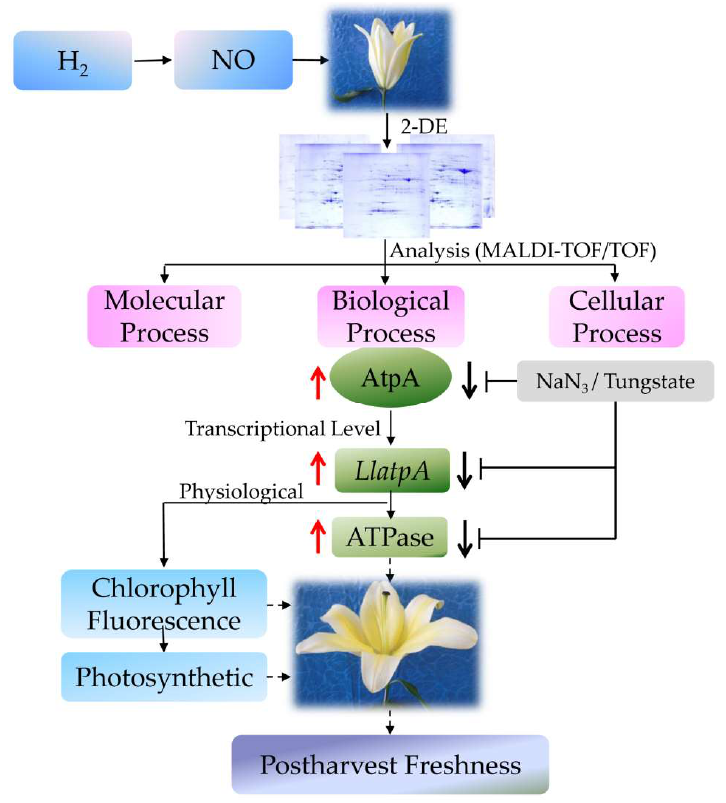
Figure 8. Schematic diagram of key proteins during nitric oxide–hydrogen gas-improved postharvest freshness in cut lily by comparative proteomic analysis.